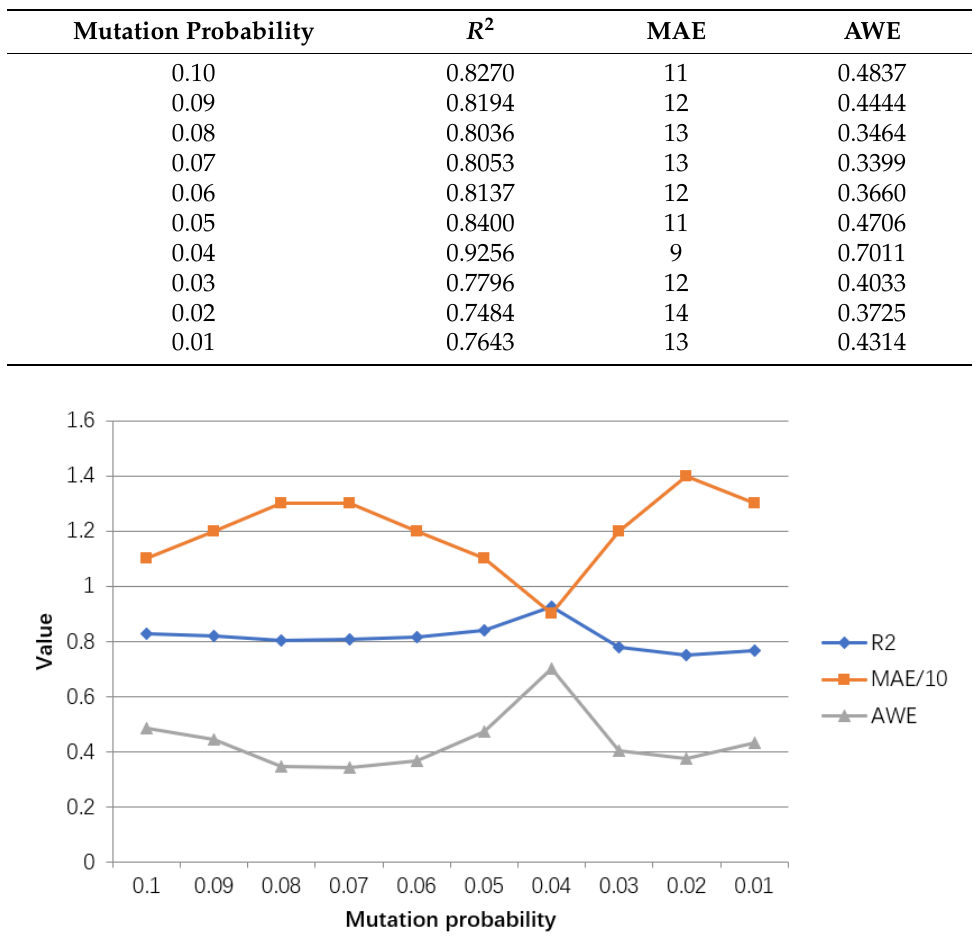
Figure 16. Line chart of adjustment results of hyperparameter mutation probability in GA-BP model. The value represents results for R2, MAE/10, AWE for different parameters